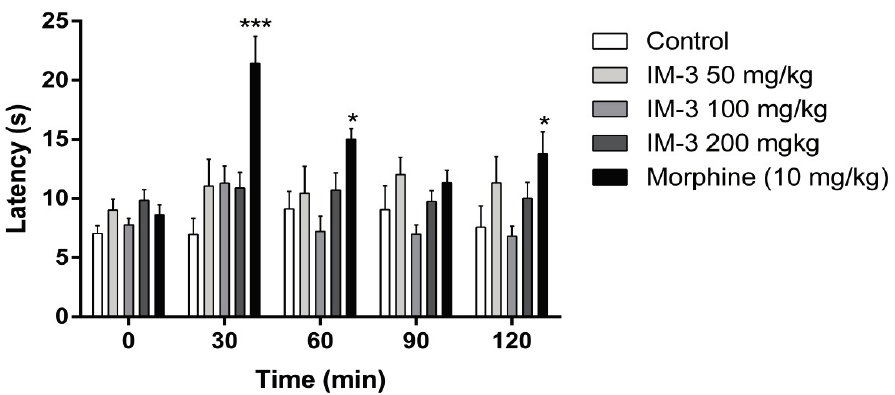
Figure 5. Effect of IM-3 on the hot plate test in mice ( n = 8). ANOVA followed by Dunnett’s test. * p < 0.05, *** p <